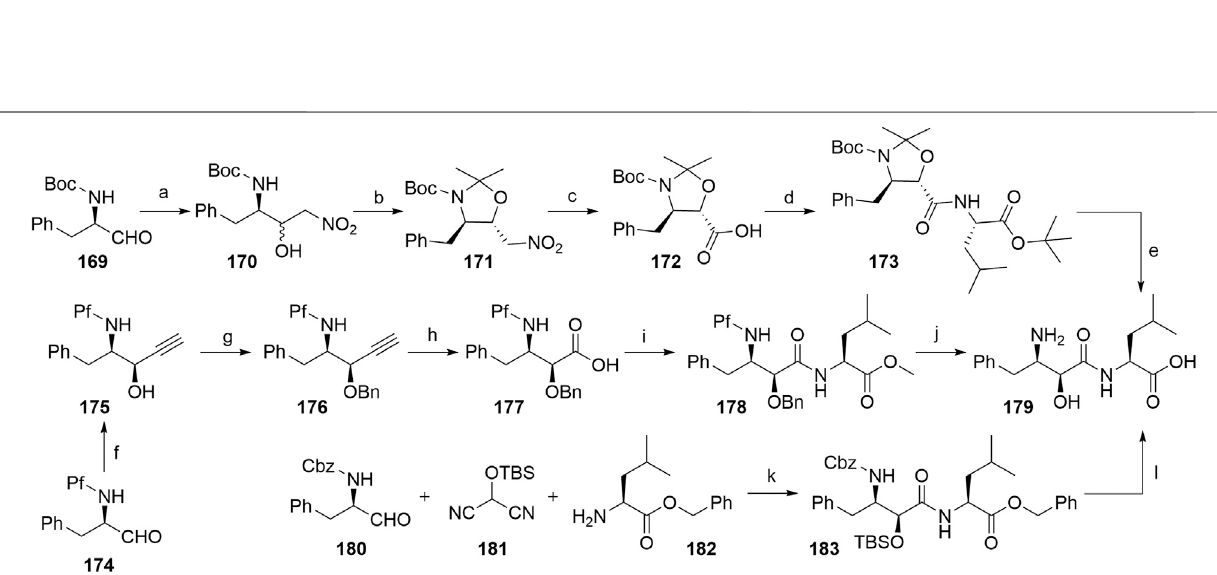
Frontiers in Chemistry |